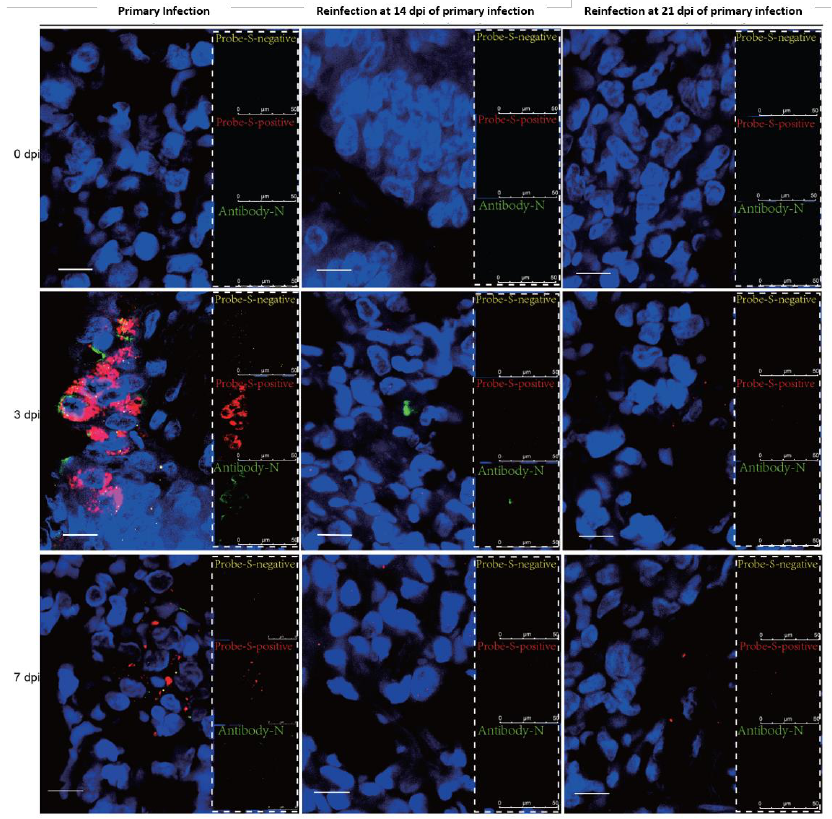
Figure 6. No viral replication was found, and a low viral load was present in the lung during reinfection, while high levels of SARS-CoV-2 viral load and replication were observed during primary infection. The distribution and abundance of SARS-CoV-2 S-mRNA and N-protein in the lung were detected by RNAscope-IF codetection at 0 dpi, 3 dpi, and 7 dpi in the primary and secondary infection groups. Yellow represents the S-mRNA-negative strand, and the signals represent the level of SARS-CoV-2 replication; red represents the S-mRNA-positive strand, and